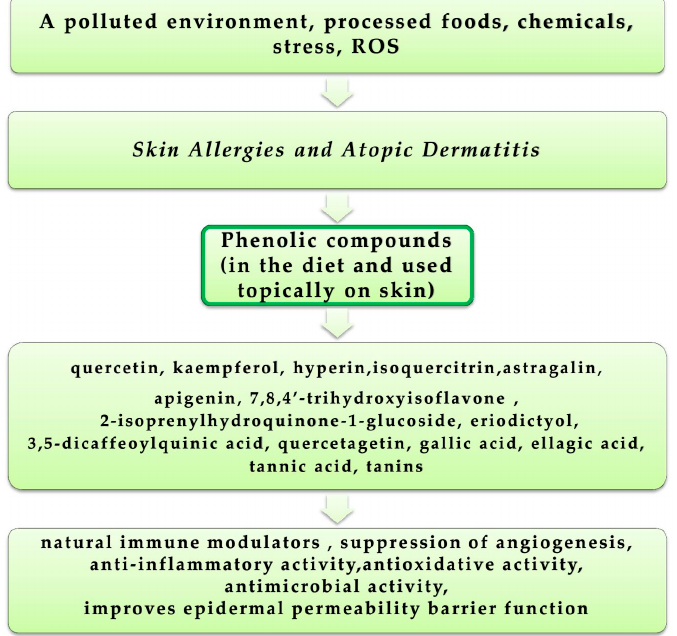
Figure 9. Anti-allergic properties of phenolic compounds.